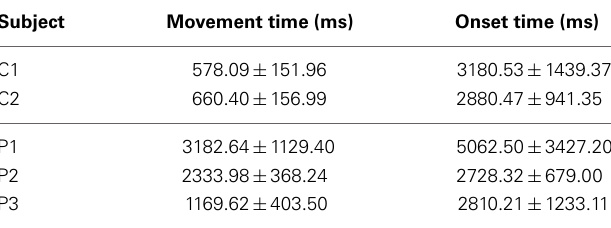
Table 6 | Time to complete reaching movements and onset time (interval between target cue presentation to start of